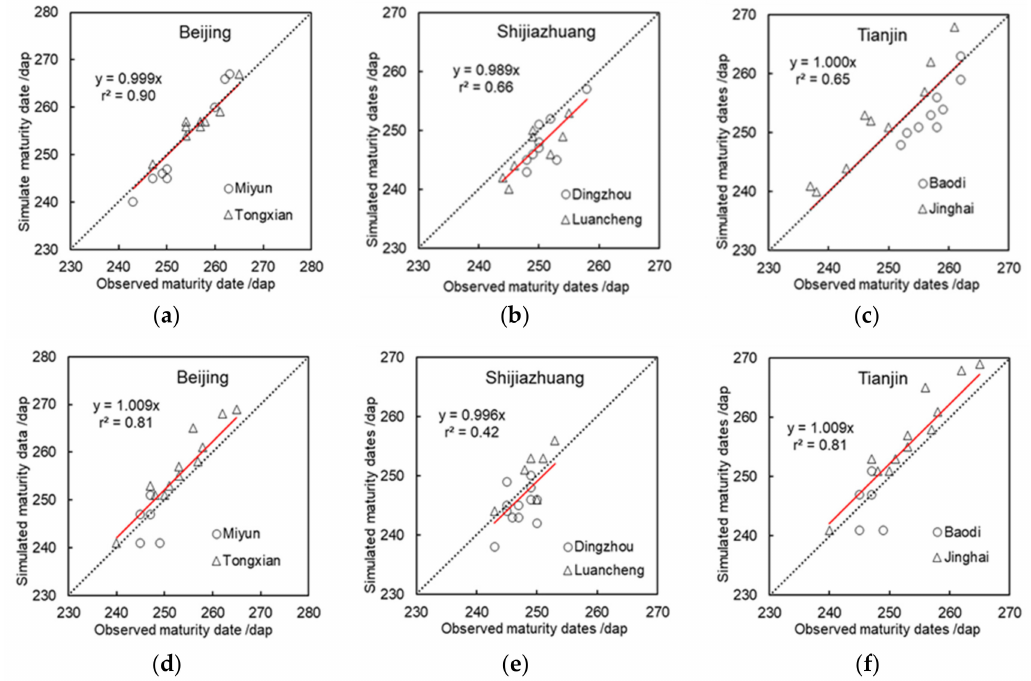
Figure 3. Calibration and validation results of the DSSAT model for maturity. ( a – c ) are calibration results for Beijing, Shijiazhuang, and Tianjin, respectively; ( d – f ) are validation results for Beijing, Shijiazhuang, and Tianjin,